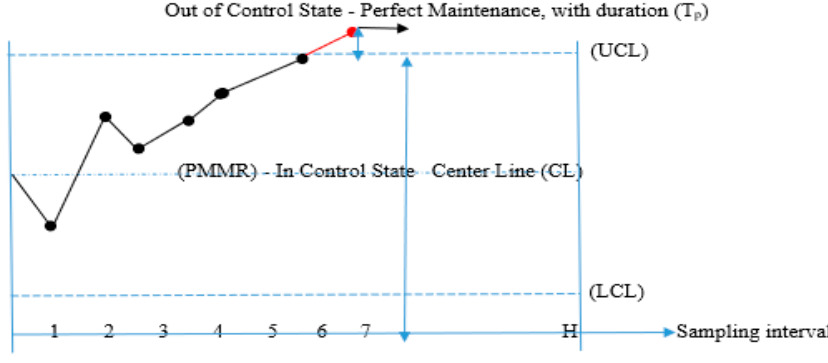
Figure 2. Control chart of quality.